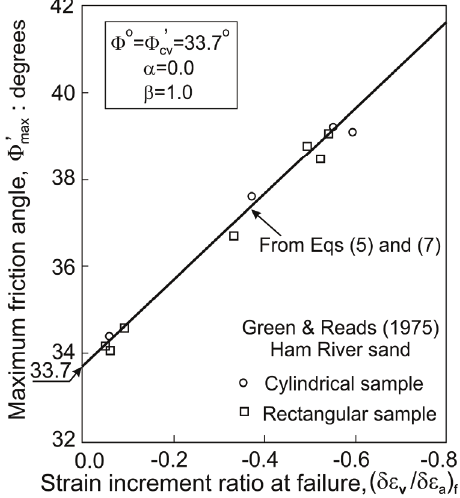
ΦΦ  ) and I D for sand vmax c